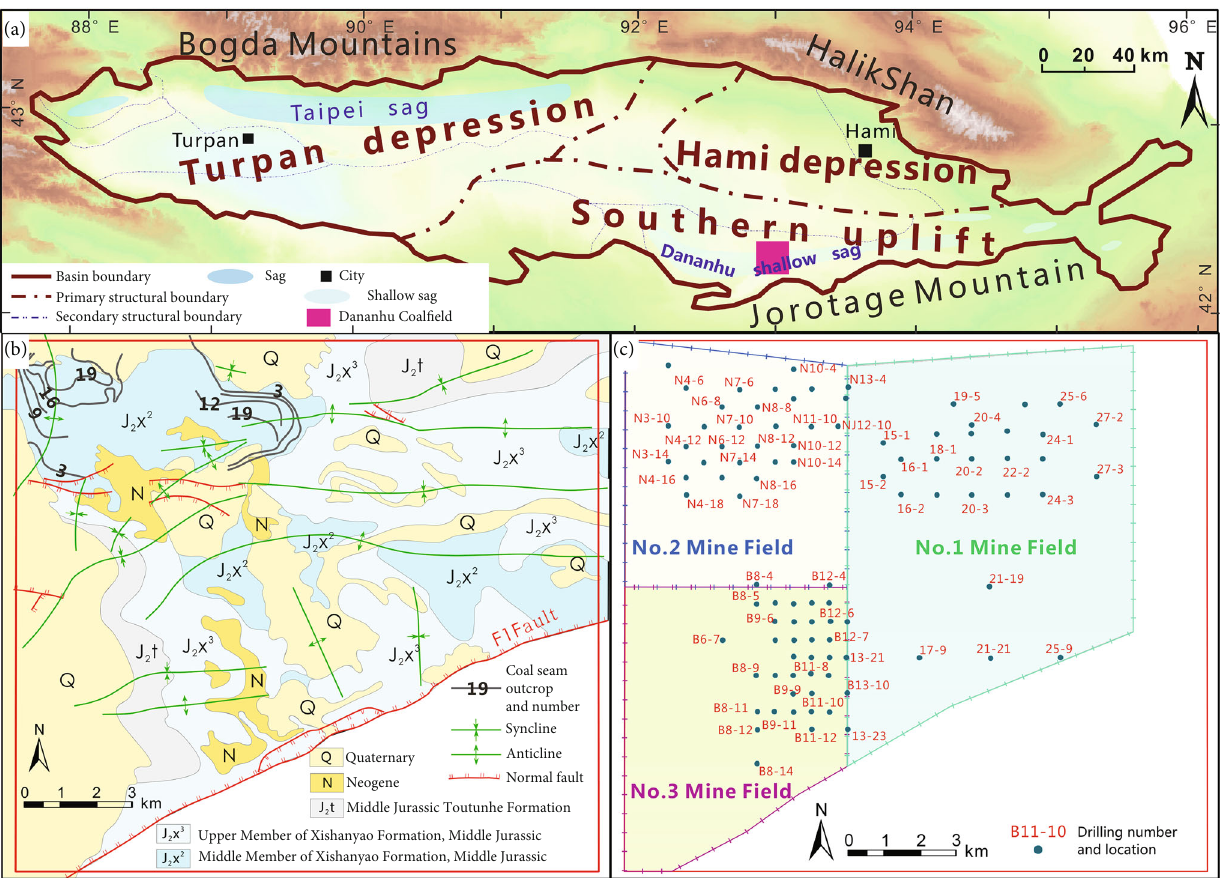
Figure 1: Geological background of western Dananhu coal fi eld: (a) regional tectonic setting; (b) geological map of study area; (c) location of